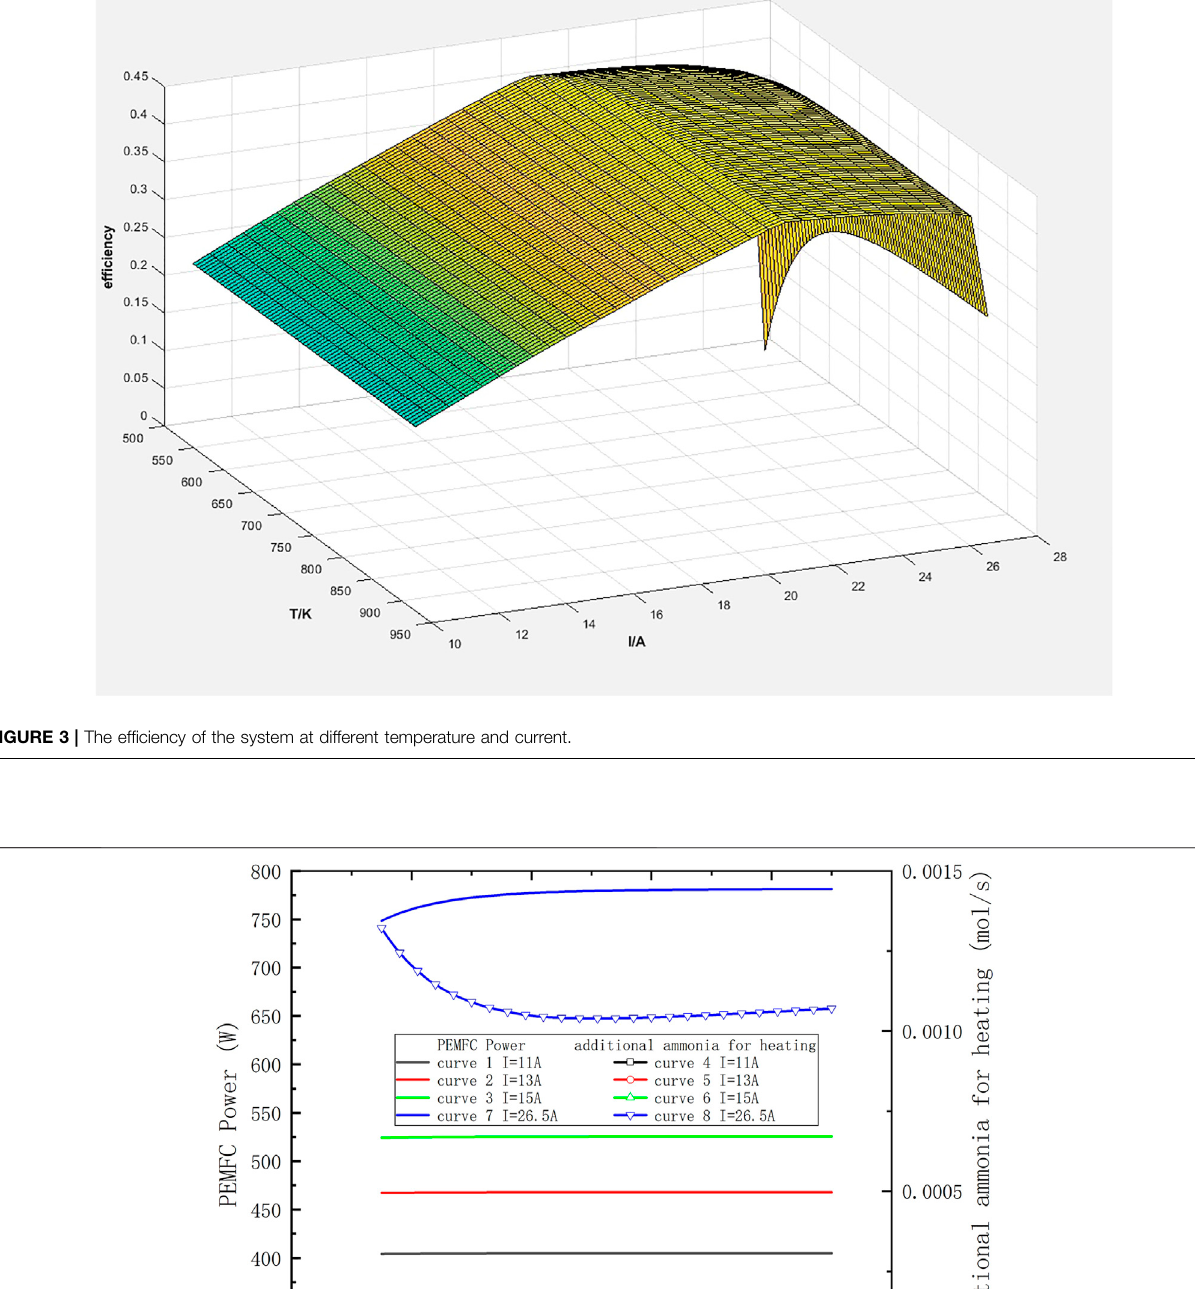
Frontiers in Energy Research |